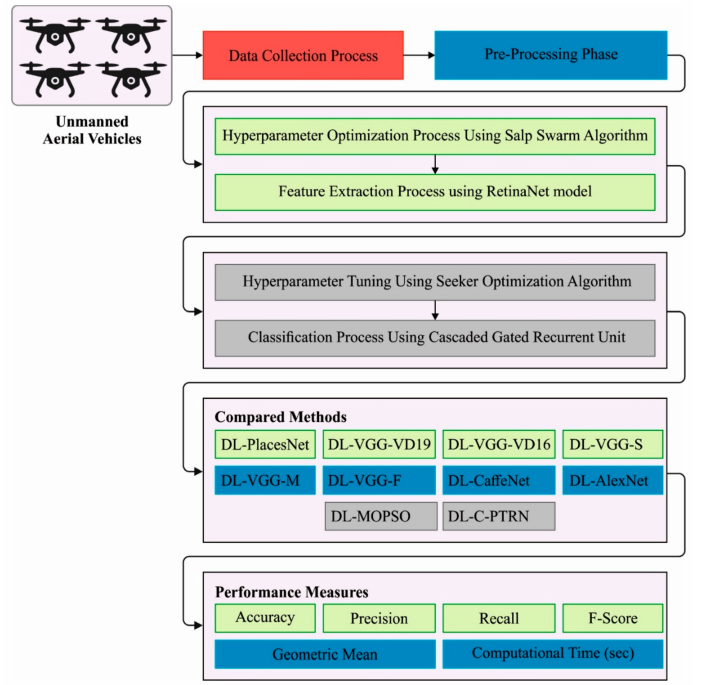
Figure 1. Block diagram of SIDTLD-AIC